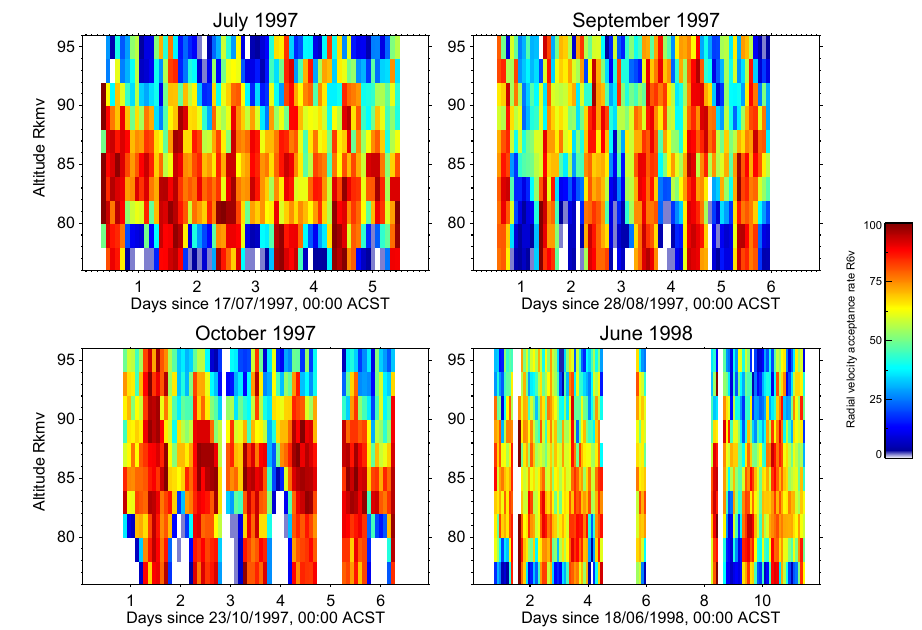
Figure 4. Acceptance rate profiles for the four HDI